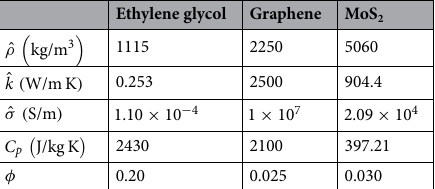
Ethylene glycol Graphene MoS